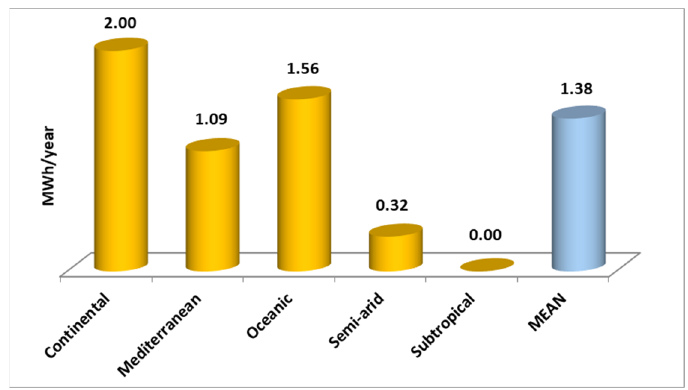
Figure 10. Mean energy consumption per household by climate zone.